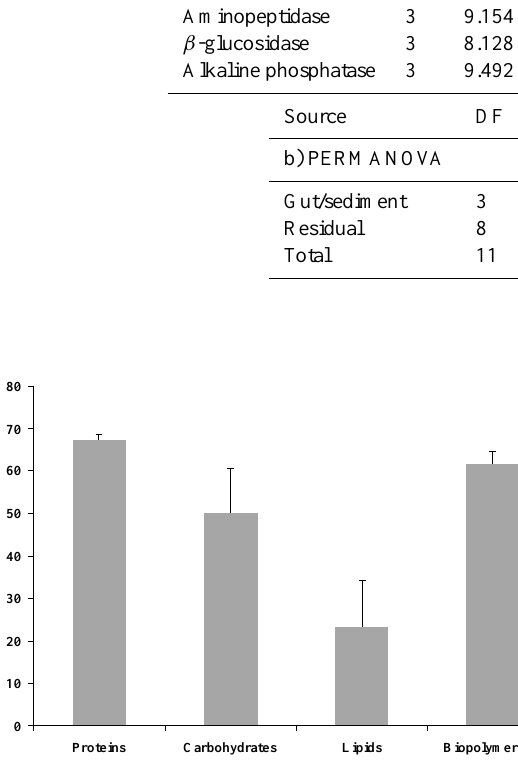
Fig. 6. Distributions of aminopeptidase, β -glucosidase and alkaline phosphatase activity through the gut of M. musculus and in sediment samples. Standard deviations are indicated. Data are expressed in nanomole of substrated released per g of sediment dry weight per hour ( n =